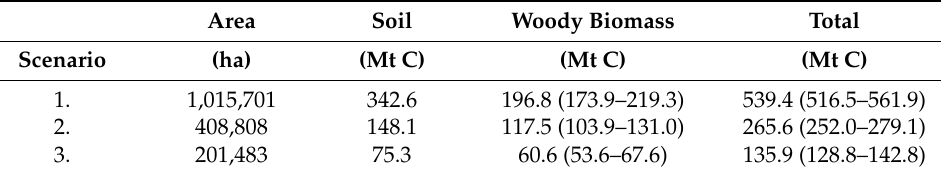
Table 3. Area (hectares, ha) and carbon stocks (million metric tons) affected by three policy scenarios centered on at-risk inventoried roadless areas. See Section 2.5. for description of scenarios. Note, the areas of these regions are not mutually exclusive and are depicted visually in Figure 4. Values within parentheses are ranges (lower and upper bound). Biomass was scaled [25] to determine lower and upper bounds using the range of ratios between the live trees measured by Forest Inventory Analysis (FIA) plot data and the other C pools (excluding soils) [12]. Soil was not scaled (see [28]), hence the lack of ranges.